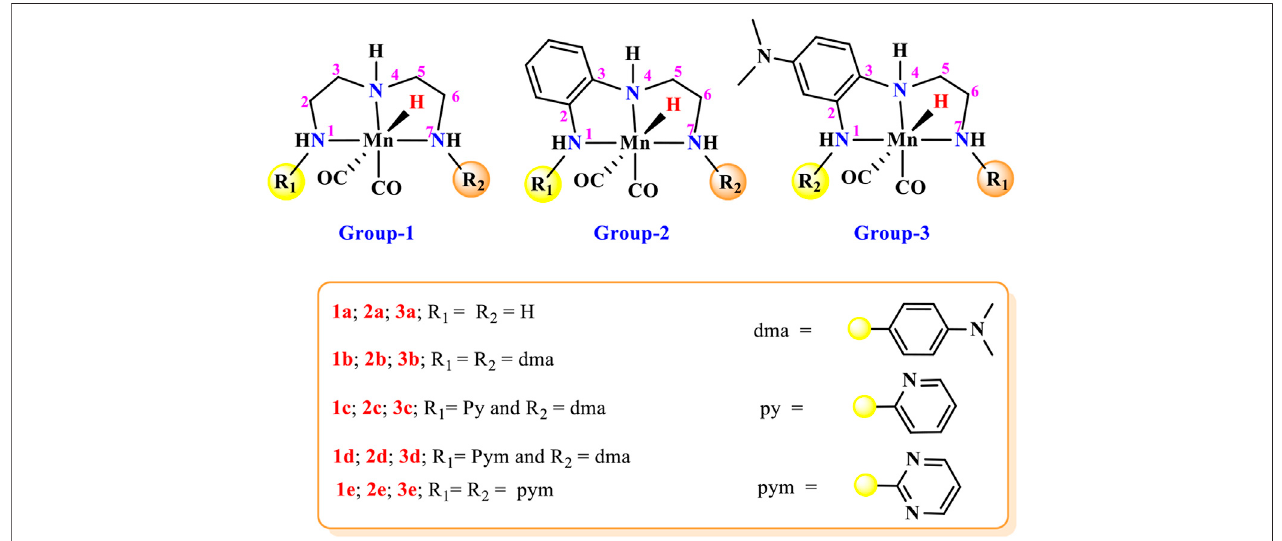
FIGURE 2 | Mn(I)NNN complexes designed for the computational study of the impact of aromatic substituents on carbon dioxide hydrogenation.